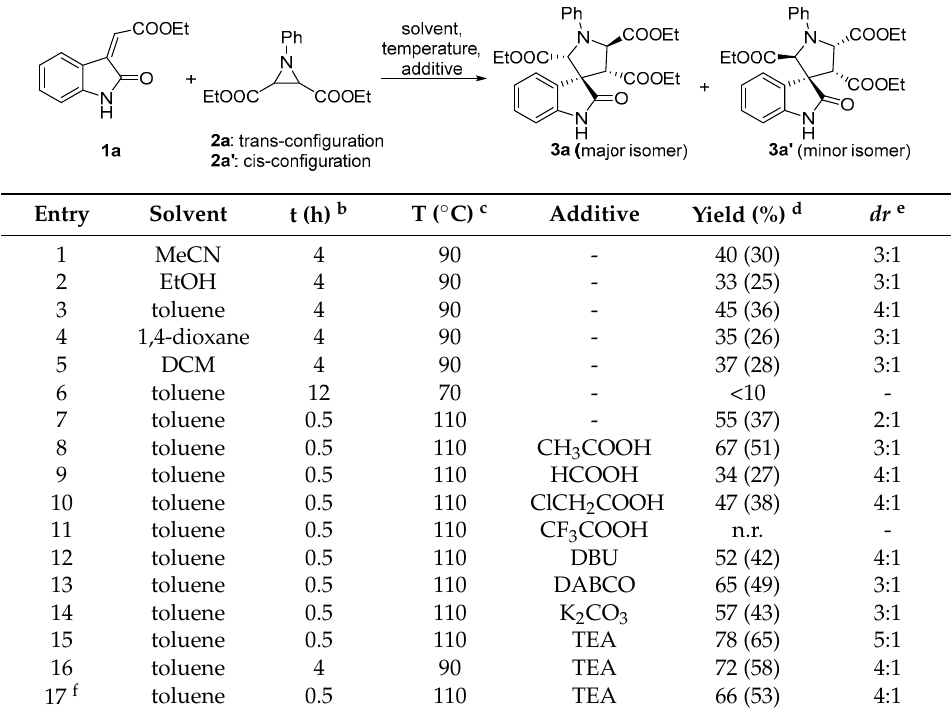
Table 1. Optimization of the reaction conditions a .